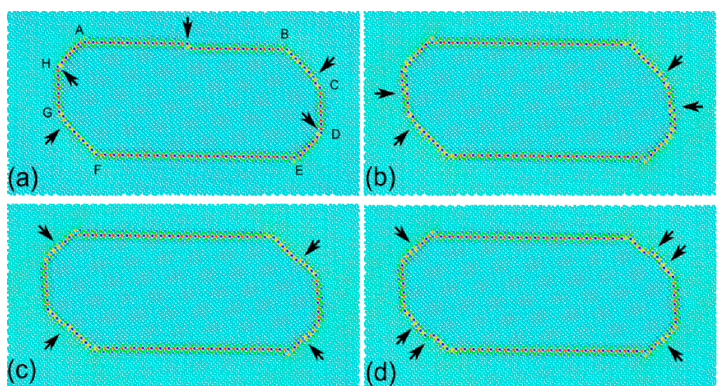
Figure 8. Different stages of twin embryo growth under applied shear strain. The faceted {1012} twin embryo is bounded by K 1 twin boundaries (AB and FE), basal-prismatic facets (AH, BC, DE, FG) and conjugate {1012} K 2 boundaries (CD and HG). Arrows point to disconnections. ( a ) Initial relaxed configuration with one disconnection in the {1012} boundary and one disconnection in two basal-prismatic boundaries; ( b, c and d ) Different stages of twin growth under applied shear strain. Arrows point to disconnections. (Reproduced from [53], with permission from Taylor & Francis Ltd., 2014).